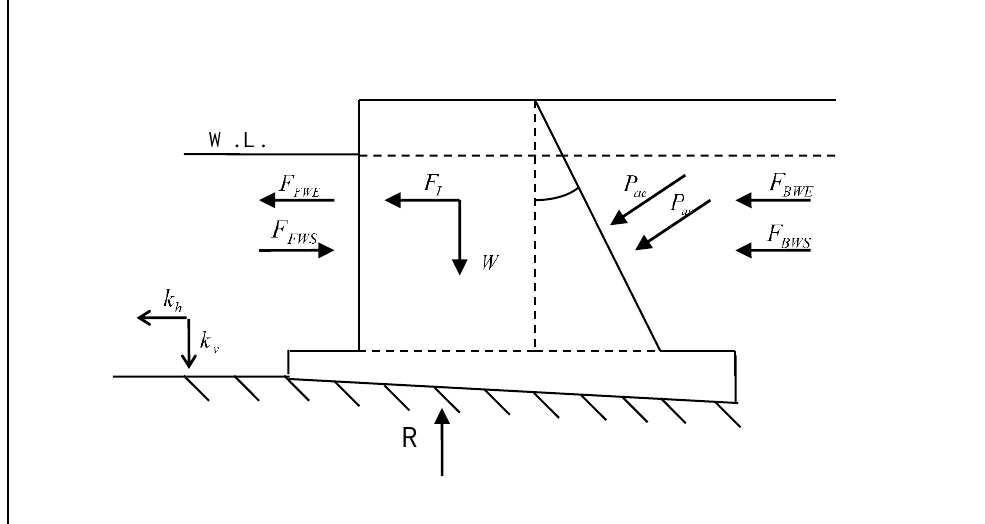
Fig. 2. Forces exerted on quay wall in seismic